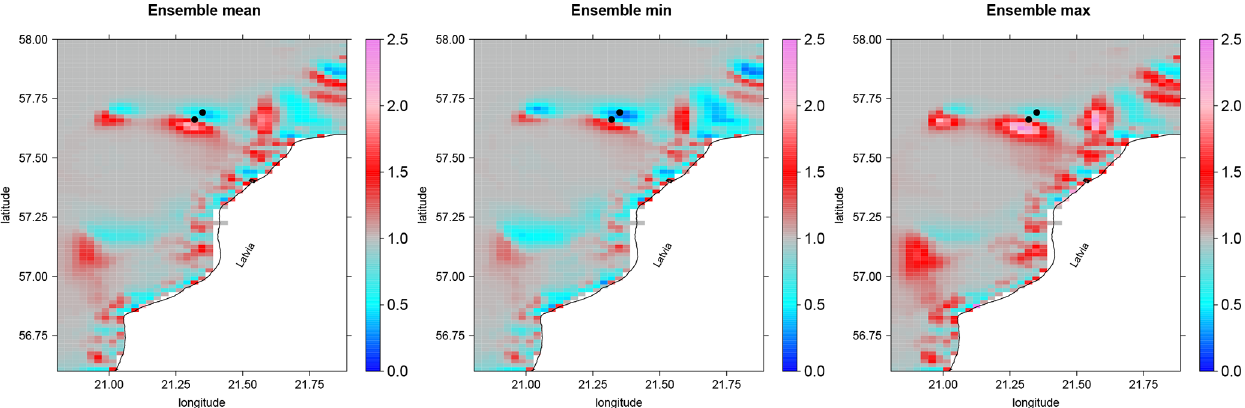
Figure 8. Ensemble mean, minimum, and maximum of the seabed concentration of PVC with a 330µm diameter on 3 January 2019 at 12:00UTC, i.e. after the storm surge event in the model, relative to the homogenous initial concentration. Dots show the locations of the grid cells selected in Fig.